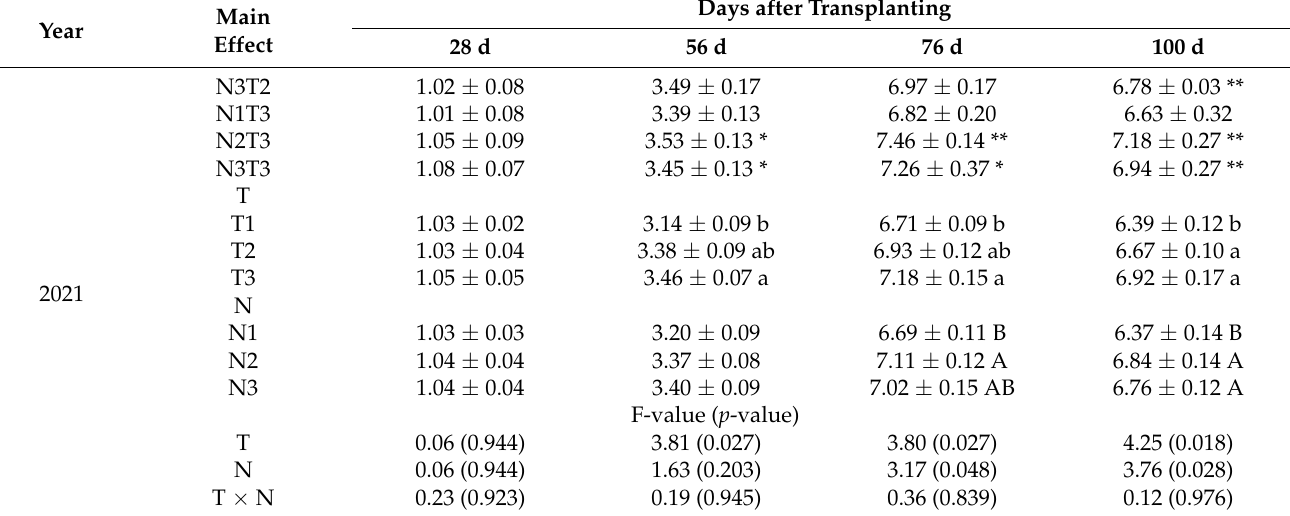
The data are all average ± standard error (the number of samples for each treatment is 9) in the table, different letters within a column indicate significant differences among all treatments, lowercase letters indicate differences between urea types, and capital letters indicate differences between N application rates; * ( p < 0.05) and ** p < 0.01) indicate the mean values that significantly differed from the control with Student’s t -test. T: urea type (urea,